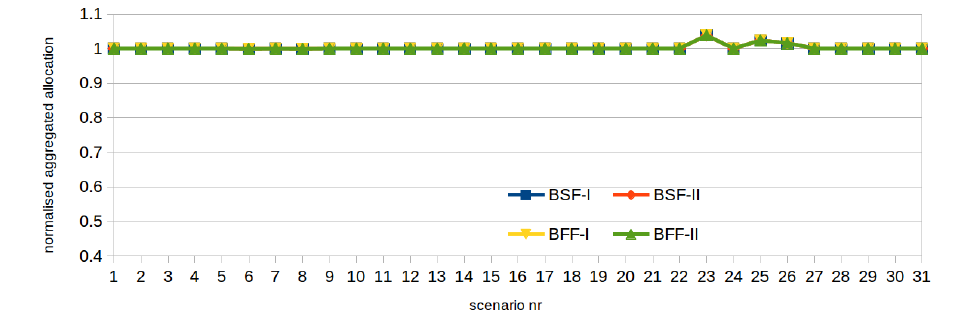
Figure 21. Aggregate allocation, normalized by NFF, for different fair allocation methods, based on the numerical results in Tables